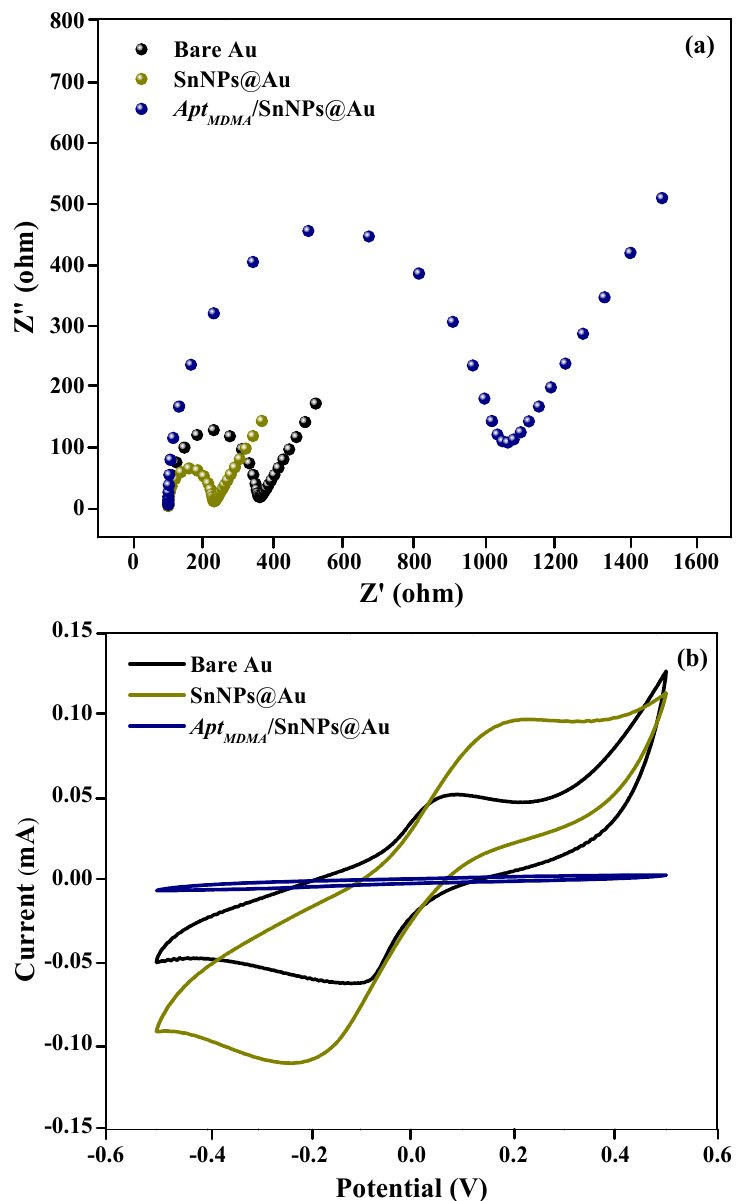
Figure 4. Electrochemical properties of tin nanoparticle (SnNPs)-based aptasensor monitored in 5.0 mM [Fe(CN) 6 ] 3 − /4 − and 0.1 M KCl electrolyte. ( a ) Electrochemical Impedance Spectroscopy (EIS) Nyquist plots of sequentially fabricated aptasensor for ( ± )-3,4-Methylenedioxymethamphetamine (MDMA) detection in the frequency range of 1.0 MHz–500 MHz, including bare Au electrode (black), SnNPs@Au (green), and Apt MDMA /SnNPs@Au (blue). ( b ) CV responses of the modified working electrode for target MDMA detection. Voltammograms are shown for bare Au electrode (black), SnNPs@Au (green), and Apt MDMA /SnNPs@Au (blue).